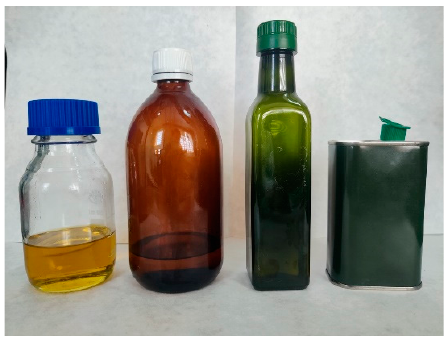
Figure 5. Different containers employed in the study.